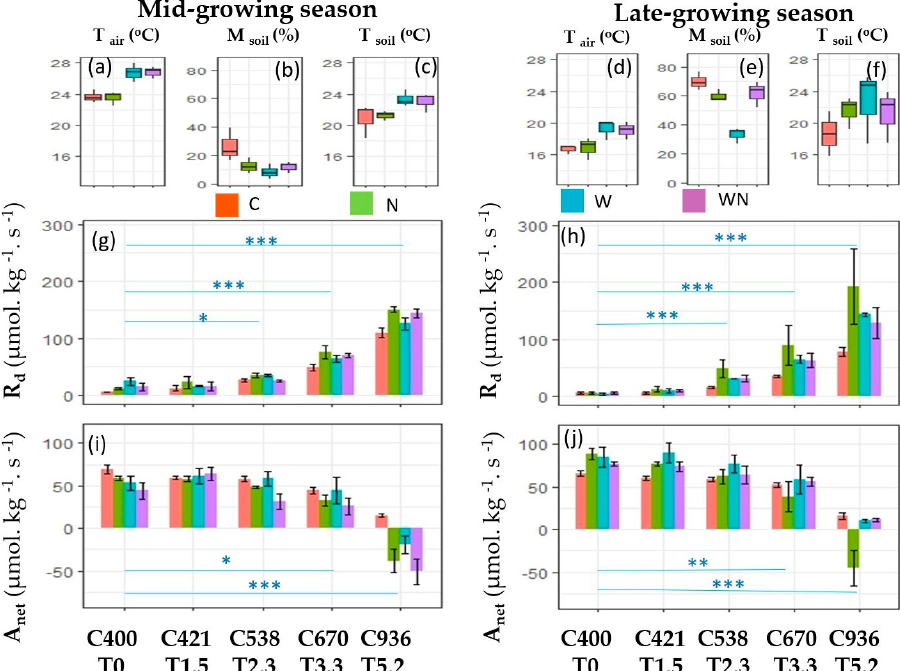
Figure 4. The dark respiration (R d ) ((g) for the mid-growing season, (h) for the late-growing season) and net photosynthesis (A net ) ((i) for the mid-growing season, (j) for the late-growing season) of T. cespitosum in both CO 2 and temperature increments (CTI) conditions stimulating future climate scenarios for the year 2100 in the Control (C-red bars), N addition (N-green bars), warming (W-blue bars) and both N addition and warming (NW-purple bars) plots. Error bars represent the standard error of the mean (n = 3). Stars indicate the p -value of the Tukey test for significant differences of R d and A net between levels of CTI (*: p < 0.05, **: p < 0.01, ***: p < 0.001). Box plots show environmental variables, including air temperature (T air ) ((a) for the mid-growing season), (d) for the late-growing season), soil moisture (M soil ) ((b) for the mid-growing season), (e) for the late-growing season), and